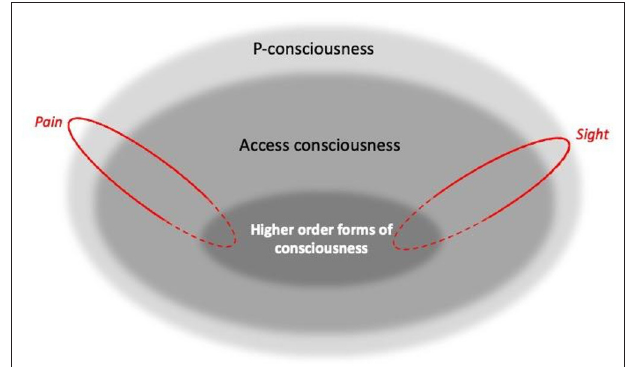
FIGURE 1 | A Venn diagram illustrating three broad, arguably hierarchical levels of consciousness [Inspired by Blackmore and Troscianko (26), Block (25), Birch (33), Birch et al. (36), Ginsburg and Jablonka (37)]. Boundaries between levels are blurred to capture how they likely vary by degrees rather than being “all or none”. Spanning the hierarchical levels are components that represent independent, dissociable sensory modalities and affective states, such as sight and pain, shown here in red (along with many others: see text). For these, solid outlines indicate parallel processing, while dashed outlines indicate the potential for diverse dimensions to be bound together (as for example during multi-modal